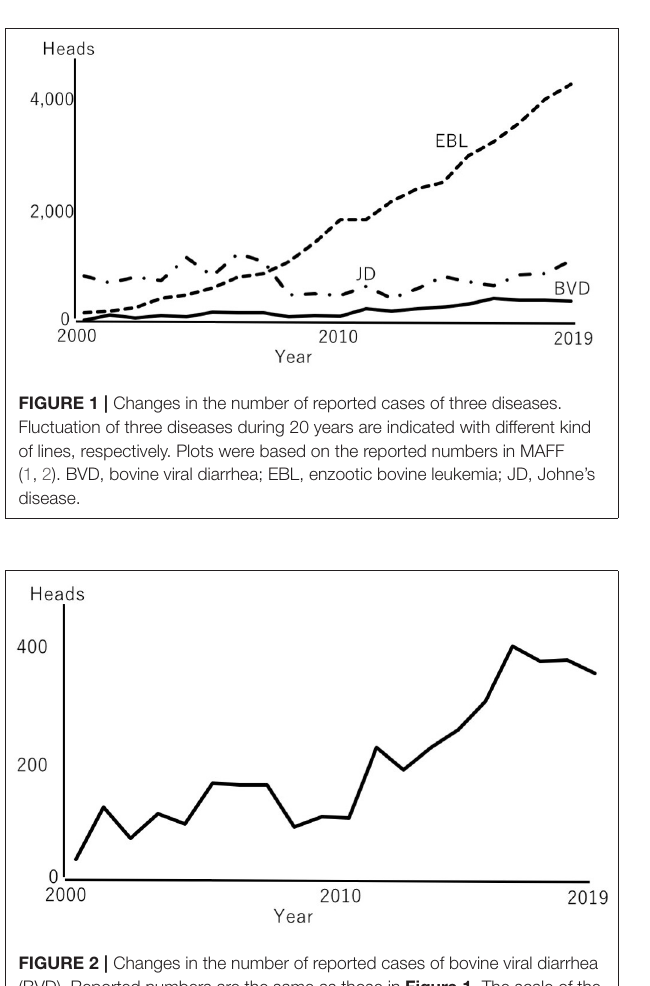
FIGURE 2 | Changes in the number of reported cases of bovine viral diarrhea (BVD). Reported numbers are the same as those in Figure 1 . The scale of the Y-axis is